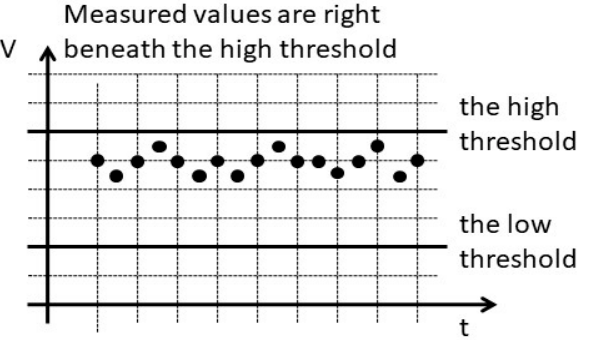
Figure 5. Limits of the threshold: the “below the high threshold” problem.